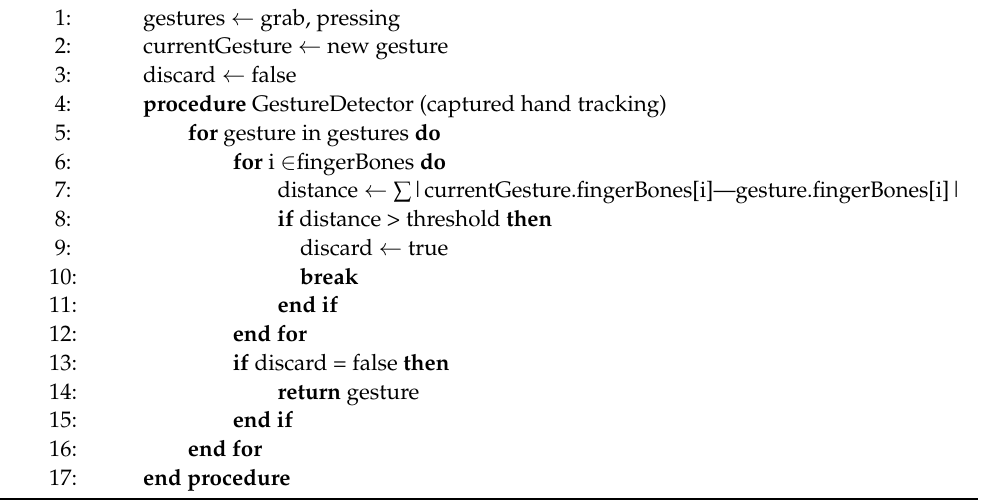
Algorithm 1. Gesture detection based on captured hand tracking